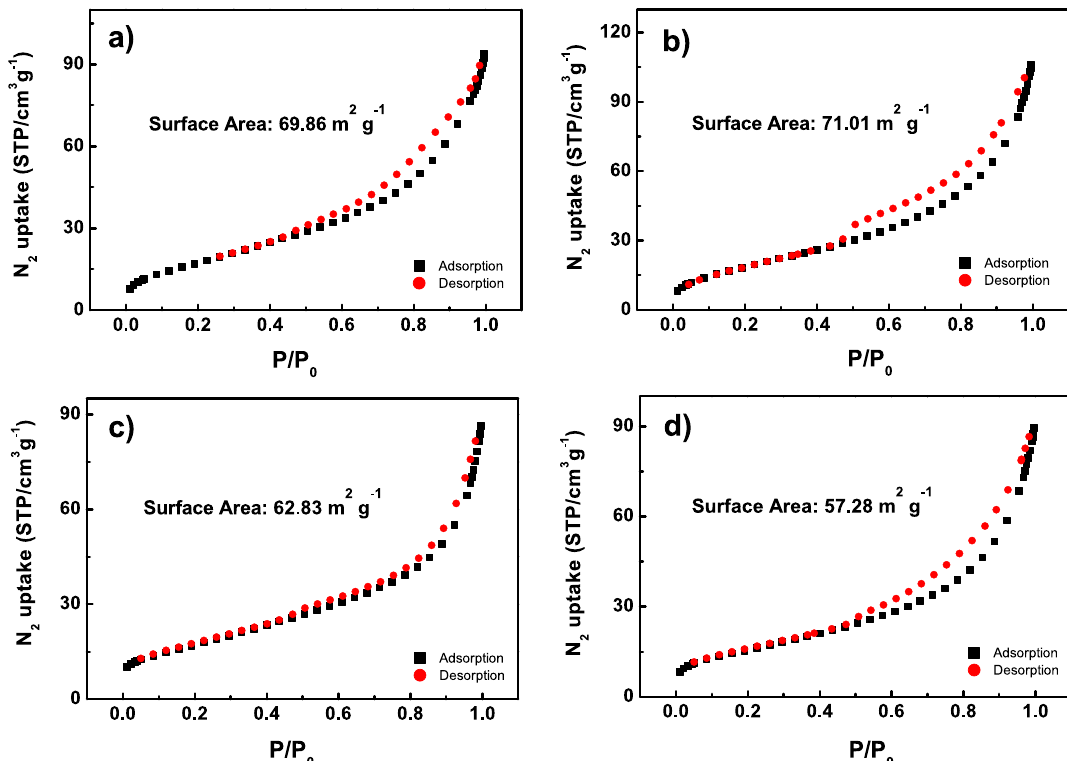
Figure 6. N 2 adsorption—desorption isotherms of the carbonized basal culm (in powdery) of ( a ) R1, ( b ) R2, ( c ) R3, and ( d )